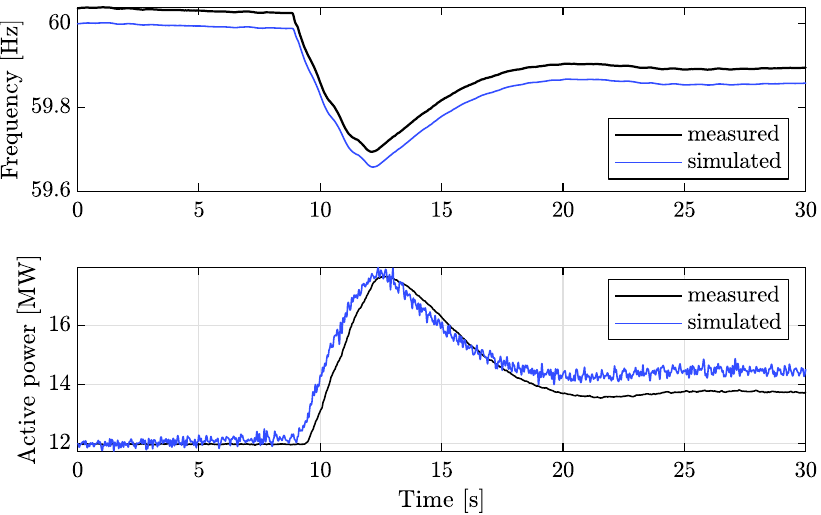
Figure 16. Frequency Control Experiment 3: reproduction of an actual grid event.